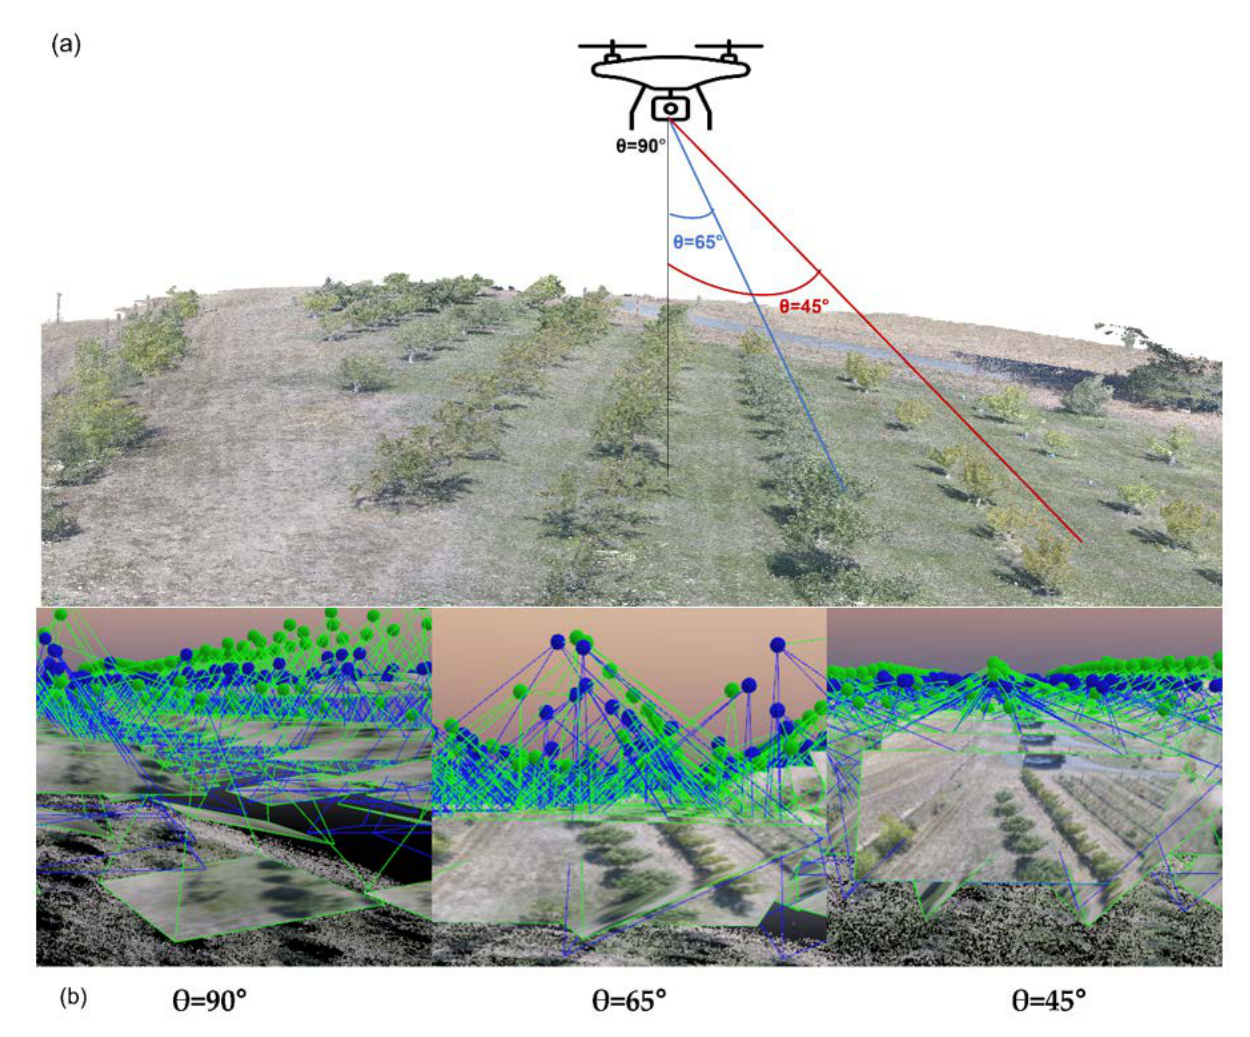
Figure 1. ( a ) Graphical representation of UAV image acquisition for each flight mission at each sensor angle (nadir and oblique angles) and ( b ) different tile points for three different imaging angles. The blue points indicate the GPS positions from the UAV (initial camera position) and the green points are the calibrated positions extracted using the Pix4Dmapper. Table 1. Summary of parameters used for UAV flight.